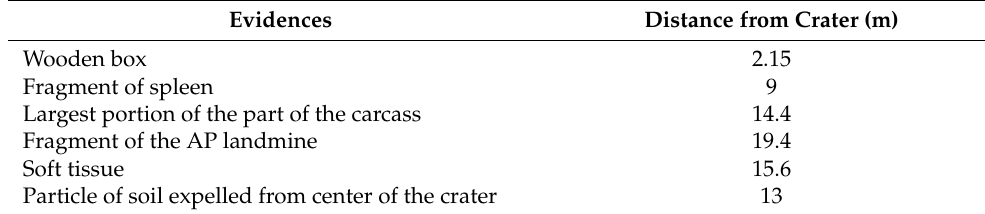
Table 1. Summary of the distance of each piece of evidence to the crater